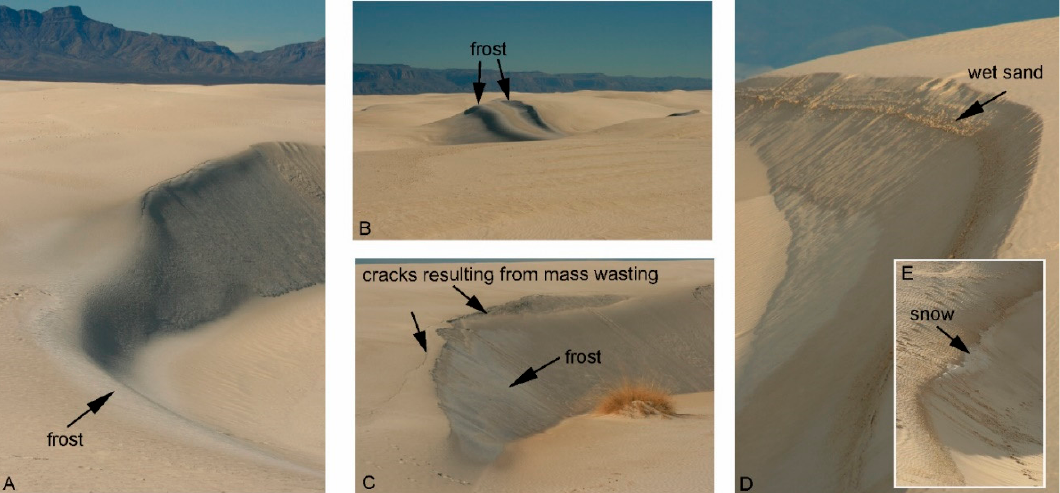
Figure 4. White Sands dunes in January of 2010 (Photographs taken by A. Szynkiewicz). ( A – C ) lighter- toned frost on dune crests and slip faces during freezing and dry conditions on 1 and 30 January. ( D , E ) snow accumulations and wetting of gypsum sand on dune crests during warmer and humid conditions on 17 January.